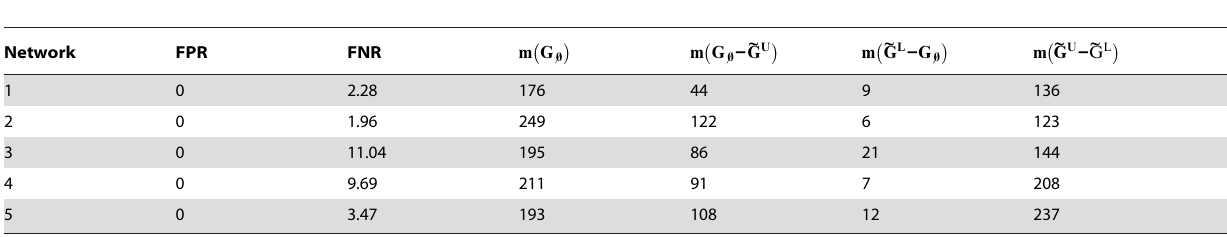
Table 5. Ensemble inference of DREAM4 100-gene gold standard networks: single-gene KO dataset.